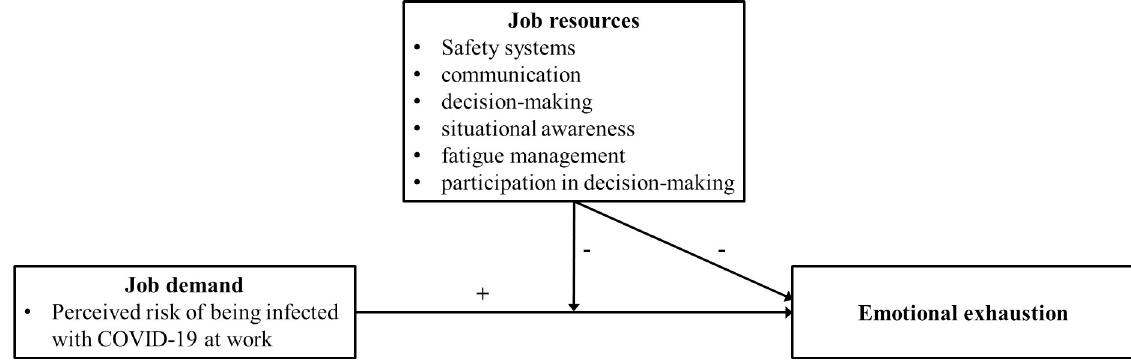
Fig 1. An application of the job demands-resources model to workplace safety during the COVID-19